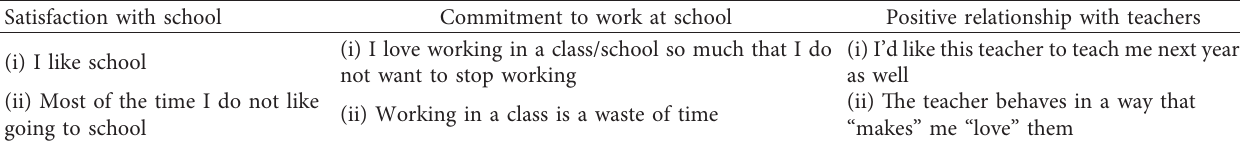
Table 1: Example of the quality of life at school scale (according to